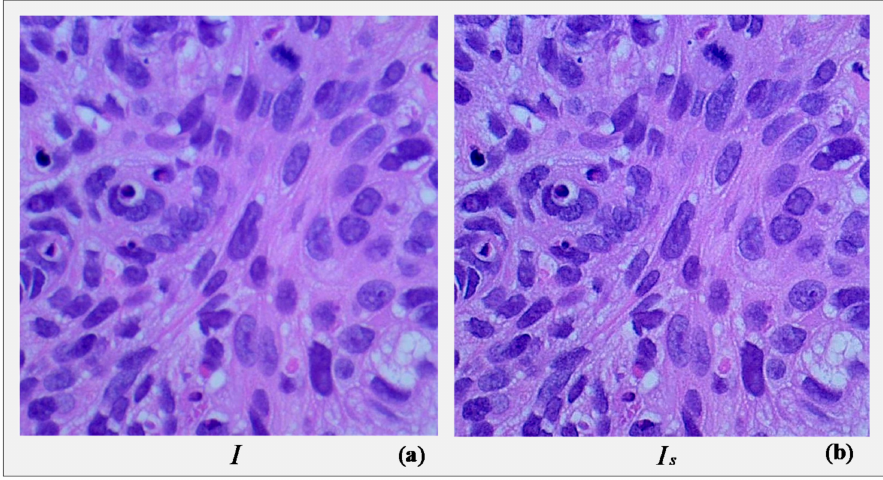
Figure 2. A sample colon cancer image ( a ) raw and ( b ) sharpened using unsharp